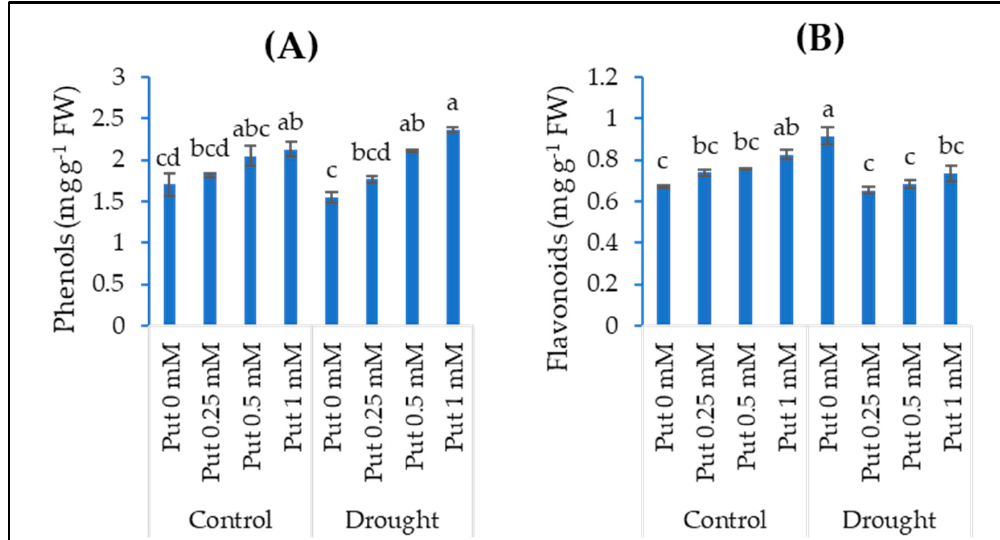
Figure 3. Change in total phenols ( A ) and total flavonoid ( B ) levels in wheat plants pretreated with putrescine, drought stressor, and their combination. Each bar shows mean ± standard error. Different letters indicate different significance between means.